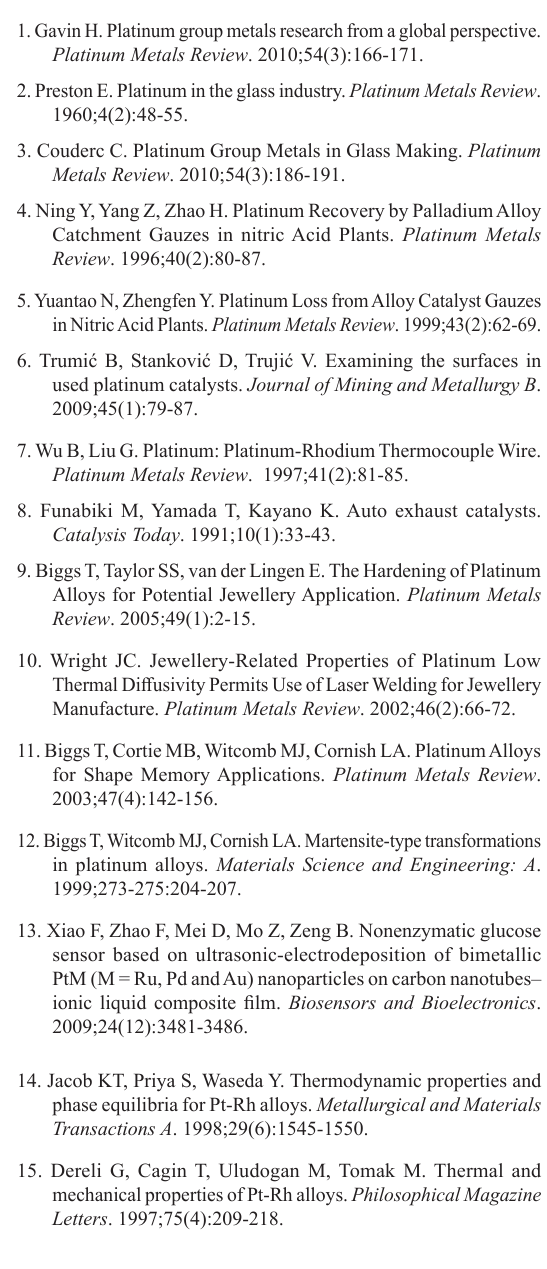
Table 8: Values of the range of deviation (Δr) for impurities